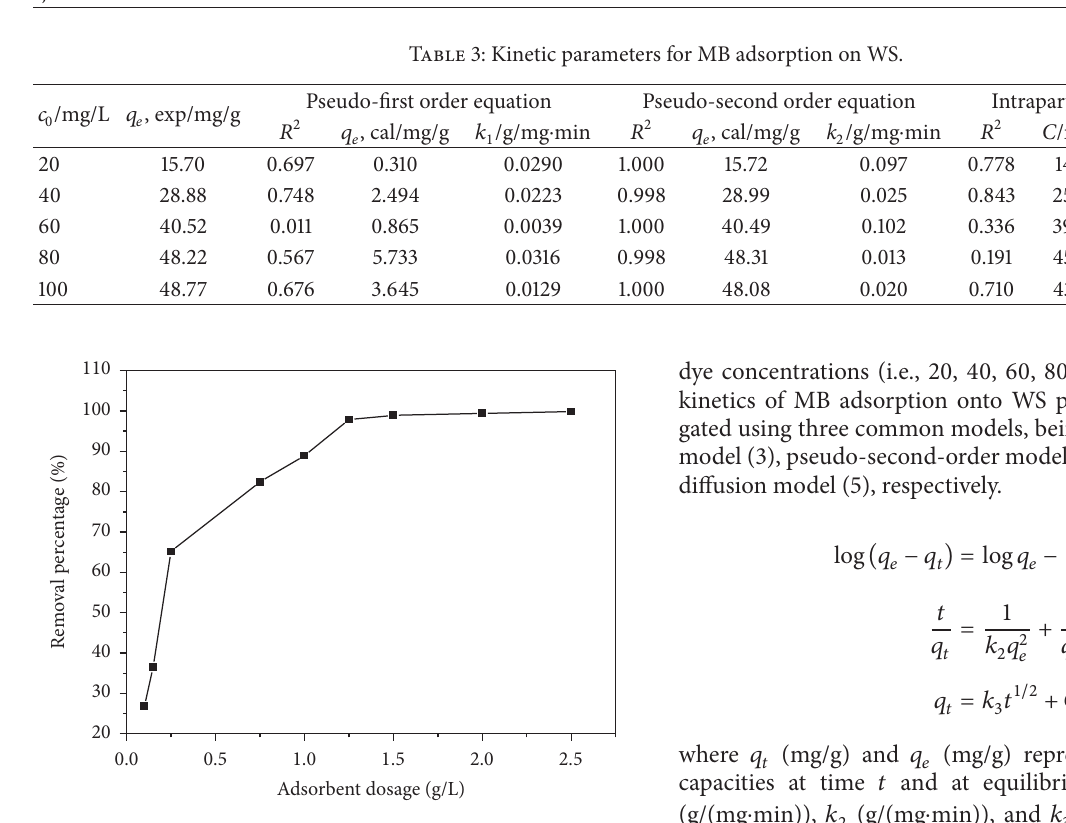
Figure 4: Effect of adsorbent dosage on the adsorption of MB by WS particles. Conditions: temperature (298 K), dye concentration (20 mg/L) and particle size (80 mesh), and contact time